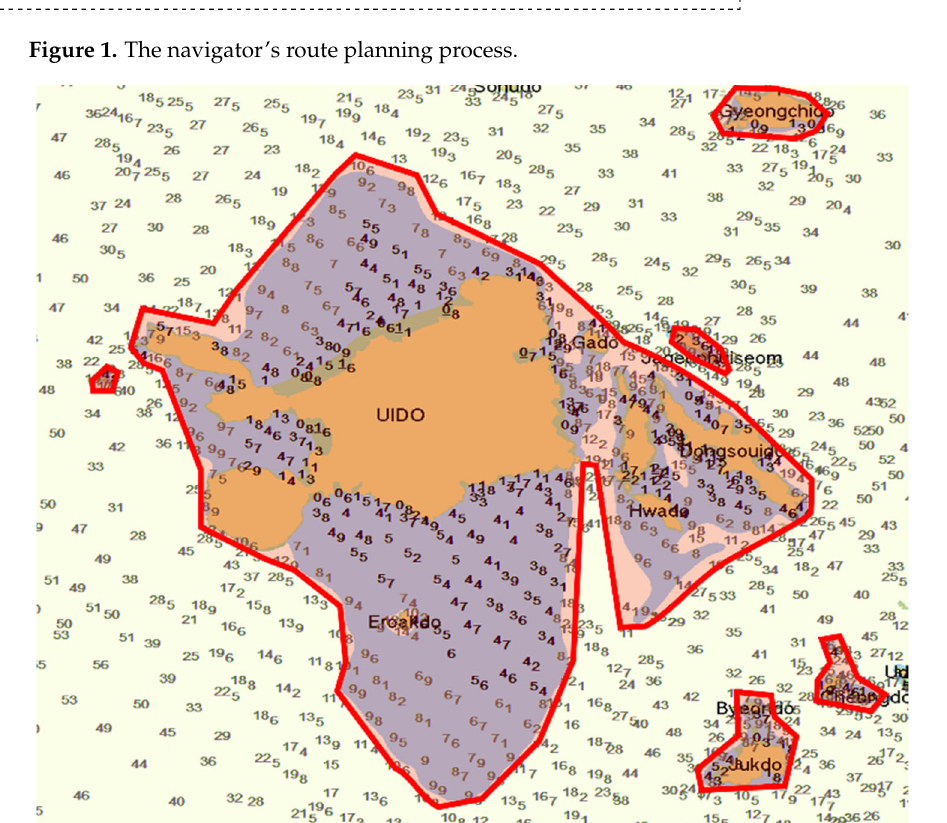
Figure 2. No go area indicates the area shaded in red, including safety depth and obstacles marked on the chart.